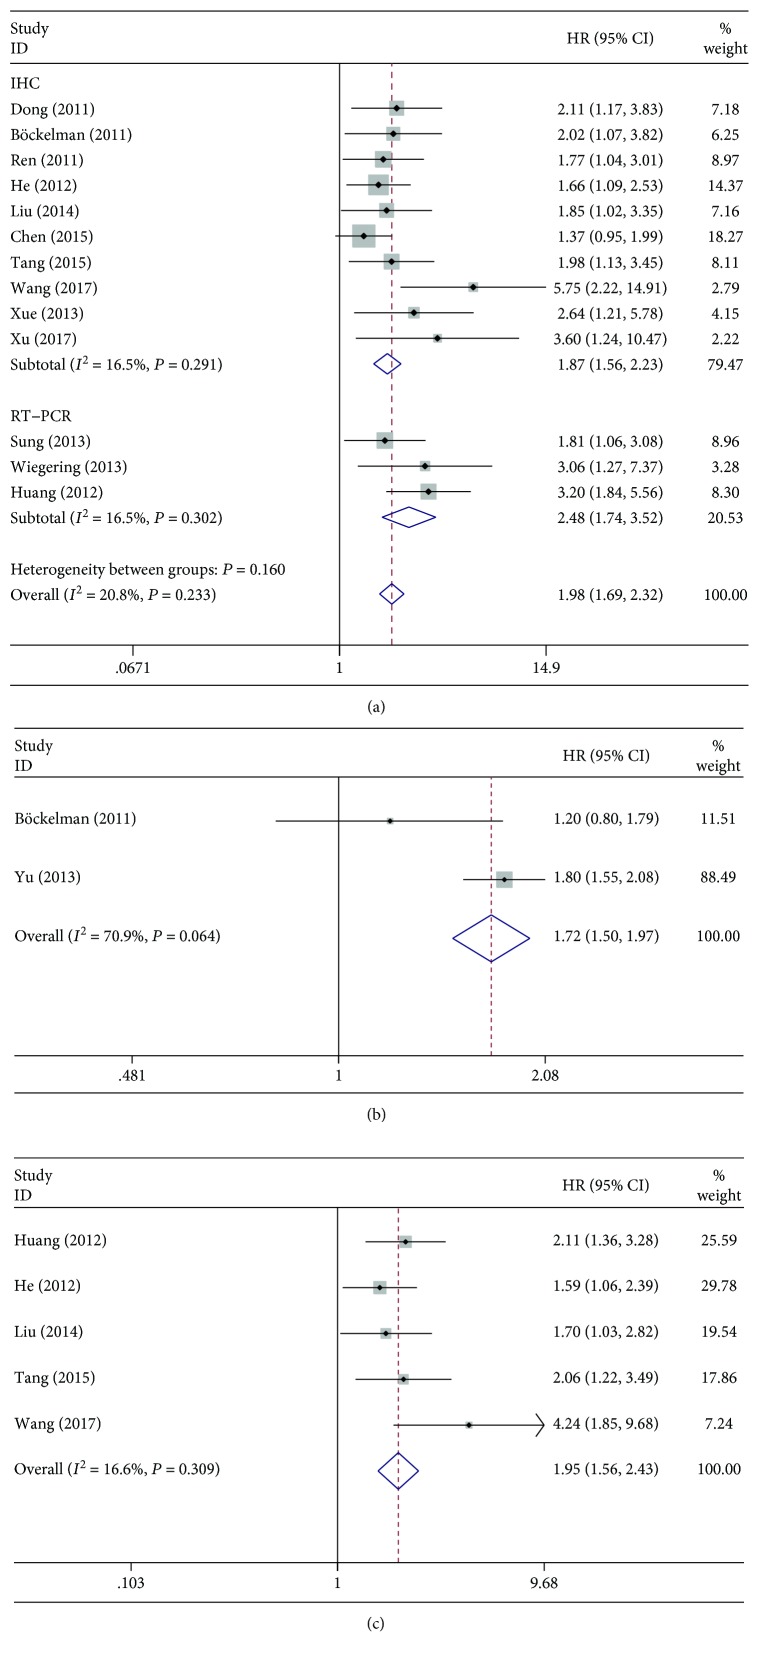
Forest plots of the meta-analysis of the association between CIP2A expression and the prognosis of patients with solid tumors. (a) Overall survival. (b) Disease-specific survival. (c) Time to tumor progression. Abbreviations: HR: hazard ratio; CI: confidence interval.